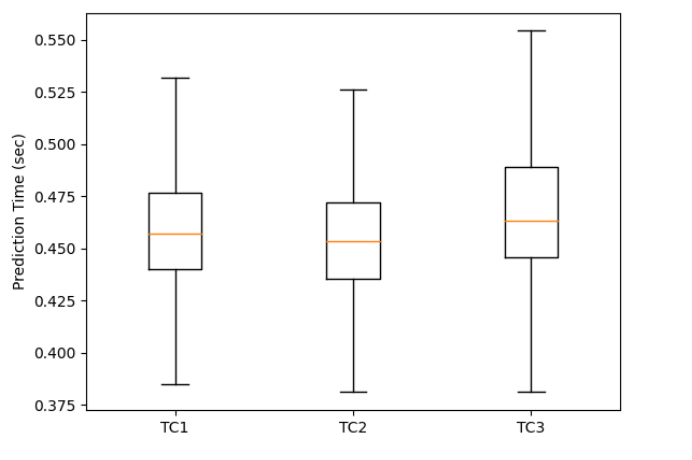
Figure 10. Average prediction time on test cases TC1, TC2, and